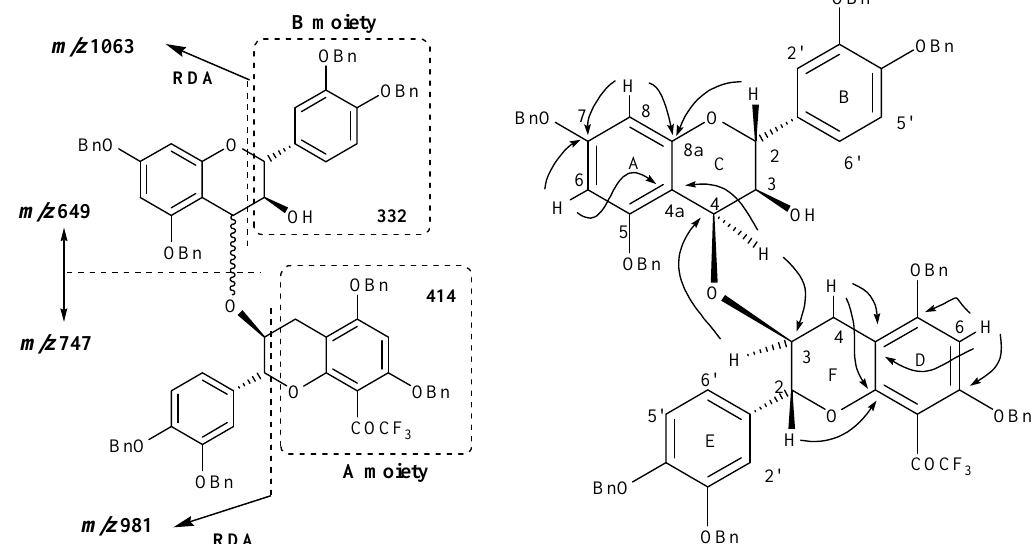
Figure 5. Main fragmentations observed and main 1 H- 13 C long range correlations observed in compound 24